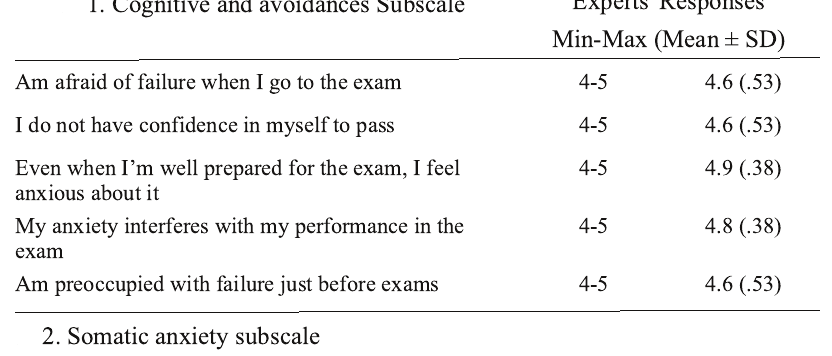
Table ofspecification and experts’ratings ofthe examination anxiety scale 1. Cognitive and avoidances